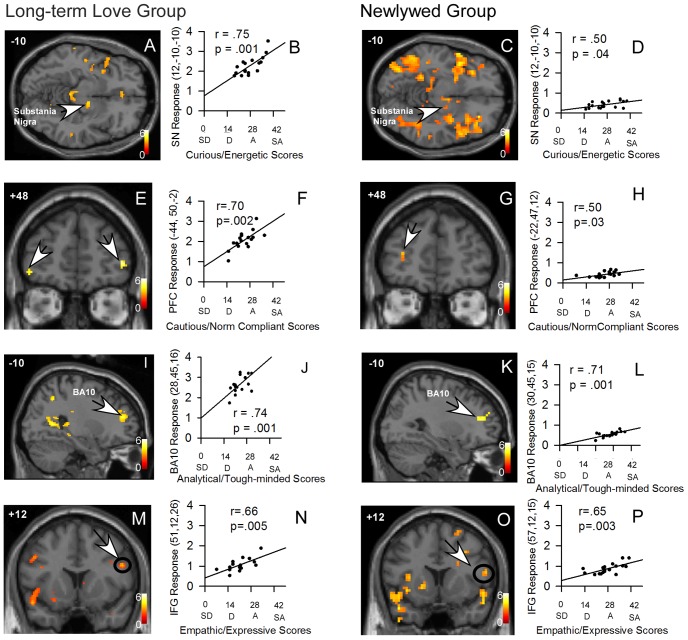
Localization of correlations with the Fisher Temperament Inventory scores.Brain images show regional activation correlated with the questionnaire scores for the four temperaments. Graphs show the correlation associated with the region indicated by an arrow in the image on its left. Peak locations were the same or within 10A.–D. The dopamine-rich substantia nigra region activation (arrows), shown in an axial image, was correlated with Curious/Energetic scores. E.–H. The ventrolateral prefrontal cortex activation (arrows), shown in a coronal image, was correlated with Cautious/Social Norm Compliant scores. The two groups showed slightly different activation areas, but both were associated with social norm compliance in another study (ref). I.–L. The dorsolateral prefrontal cortex activation (arrows, BA10), shown in a sagittal image, was correlated with Analytical/Tough-minded scores. M.–P. The inferior frontal gyrus activation (arrows), shown in a coronal image, was correlated with Empathic/Expressive scores. The Long-Term Love experiment was done first, and regions of interest for the Newlywed experiment analysis were based on it. BA10, Brodmann’s Area 10, dorsolateral prefrontal cortex. IFG, inferior frontal gyrus. PFC, prefrontal cortex, ventrolateral. SN, substantia nigra. The color scale shows t-scores. MNI template: right in the image is right side of brain. Graphs x axes: SD, strongly disagree; D, disagree; A, agree; SA, strongly agree.